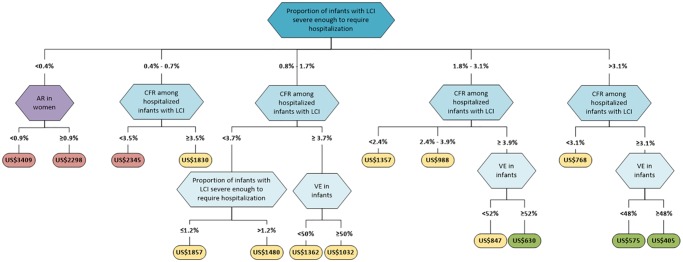
Regression tree analysis of 10,000 Monte Carlo simulations sampling across the uncertainty in all parameters.The leaves of the tree end in ovals that show the mean cost per DALY of maternal influenza vaccine among all simulations whose parameters follow the paths described in the proximal branches. Further partitioning of this pruned, cross-validated tree did not reduce generalization error. Parameters affecting infant influenza are shown in shades of blue, while parameters affecting influenza in women are shown in purple. Cost-effectiveness ratios < 1x per-capita GDP in Mali are shown in green, those between 1x and 3x per-capita GDP in Mali are shown in yellow, those >3x per-capita GDP in Mali are shown in red. LCI: Lab-confirmed influenza; CFR: case-fatality ratio; VE: vaccine efficacy.